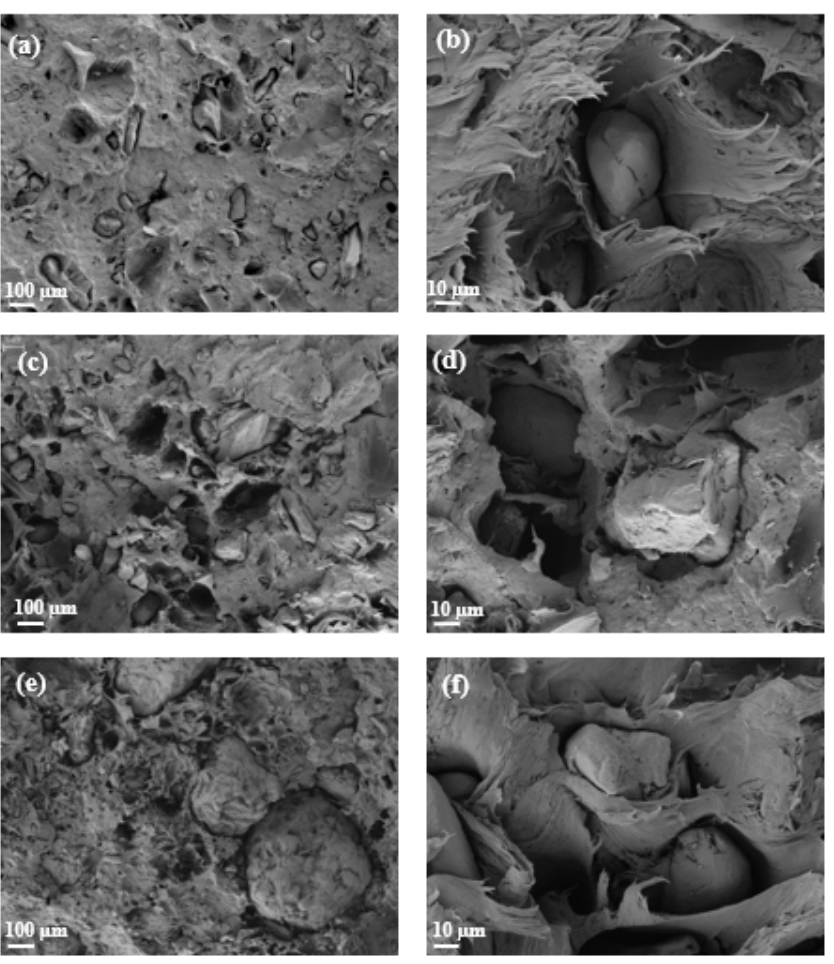
Figure 18. SEM micrographs of composites: ( a ) 25OP-rPP (500 × ); ( b ) 25OP-rPP (2000 × ); ( c ) 40OP-rPP (500 × ); ( d ) 40OP-rPP (2000 × ); ( e ) 40OP/PA-rPP (500 × ); ( f ) 40OP/PA-rPP (2000 × ).